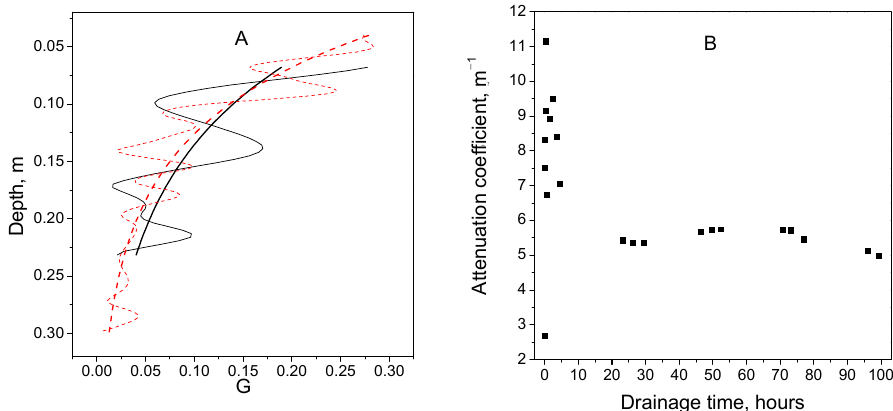
Figure 8. Experiment 1: ( A ) trace envelopes (G, Equation (9)) obtained before moistening (black) and immediately after moistening (red) and their exponential approximations; ( B ) coefficient of attenuation of electromagnetic waves as function of time of water drainage.